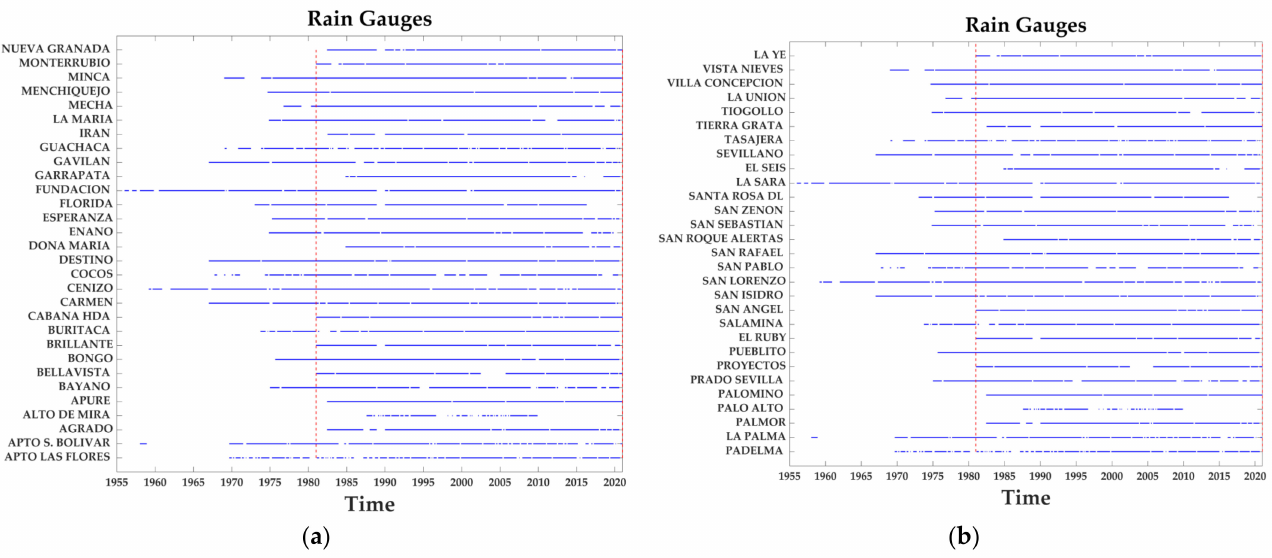
Figure 2. ( a , b ) Rain gauges used to validated CHIRPS data (downloaded from IDEAM website—http://dhime.ideam.gov. co/atencionciudadano/, accessed on 12 December 2020). The horizontal lines show the period covered by each IDEAM station, and the vertical dotted line indicates the starting period where the CHIRPS data and IDEAM rain gauges are compared (January